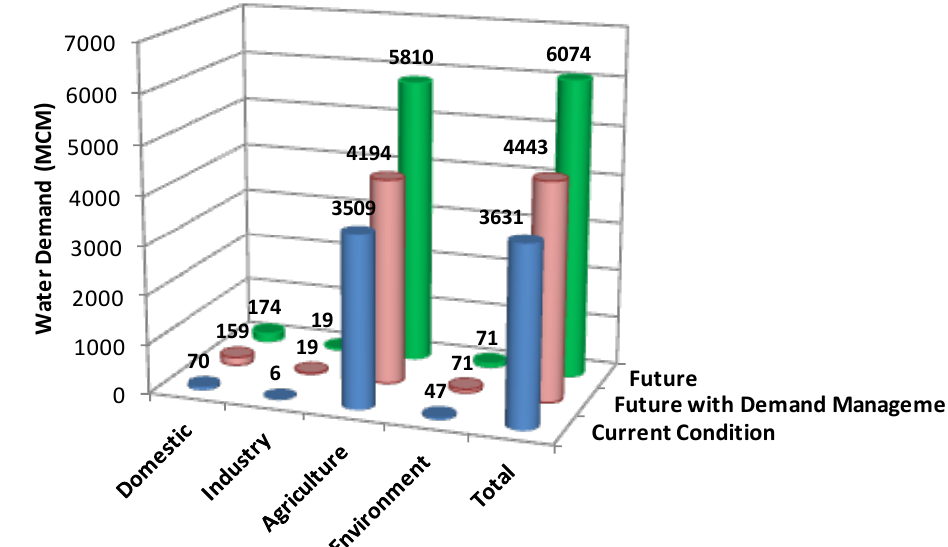
Figure 3. Water demands of different sectors of Hamoon- Jazmorian basin area in current and future conditions